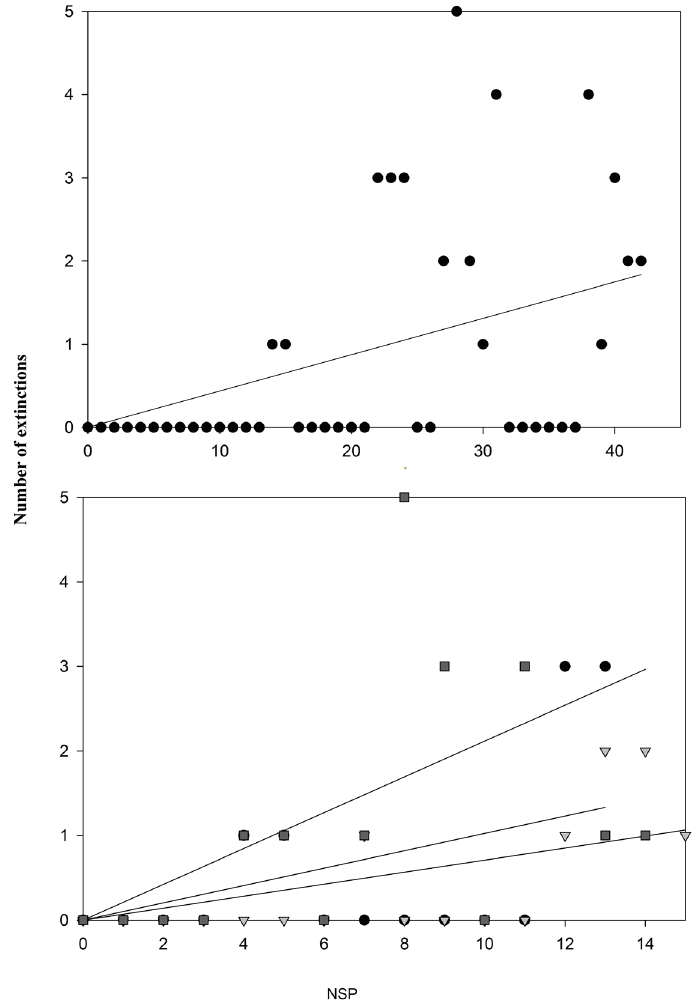
Figure 2. Plots of the number of extinctions versus the number of species present at the time of extinction. Upper panel, all species; Lower panel, species segregated into three body mass